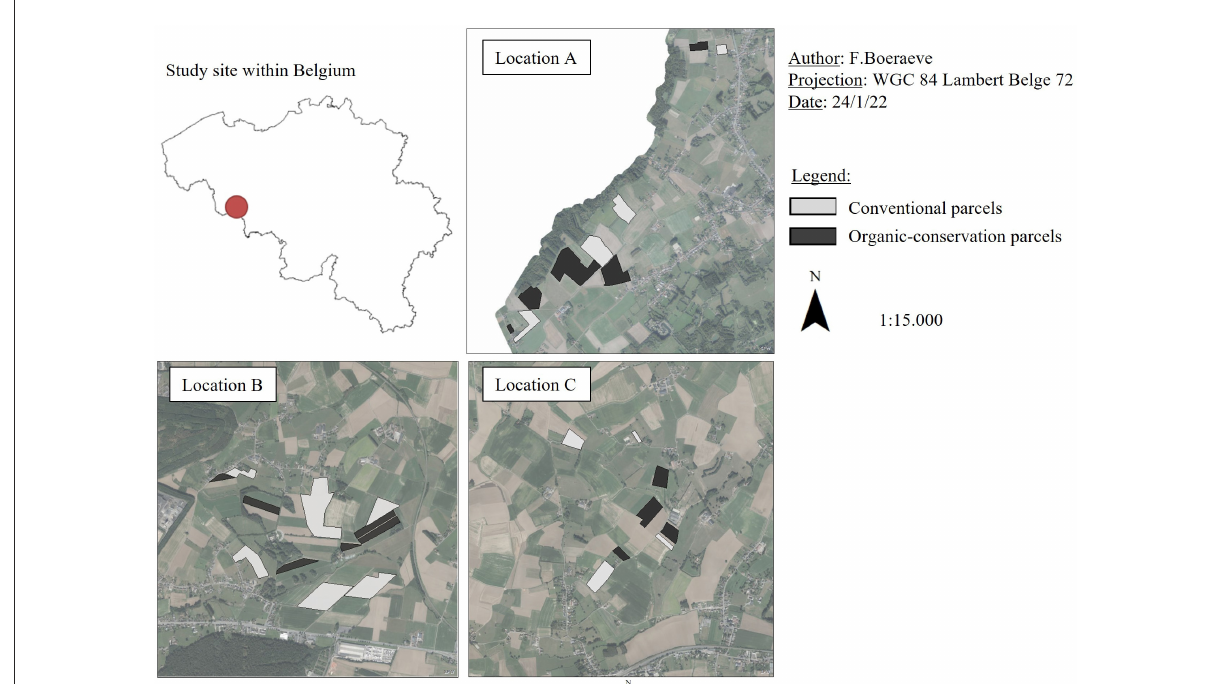
FIGURE1 Maps of the study site within Belgium (red dot), the three locations (A, B, C), conventional parcels (light gray) and organic-conservation parcels